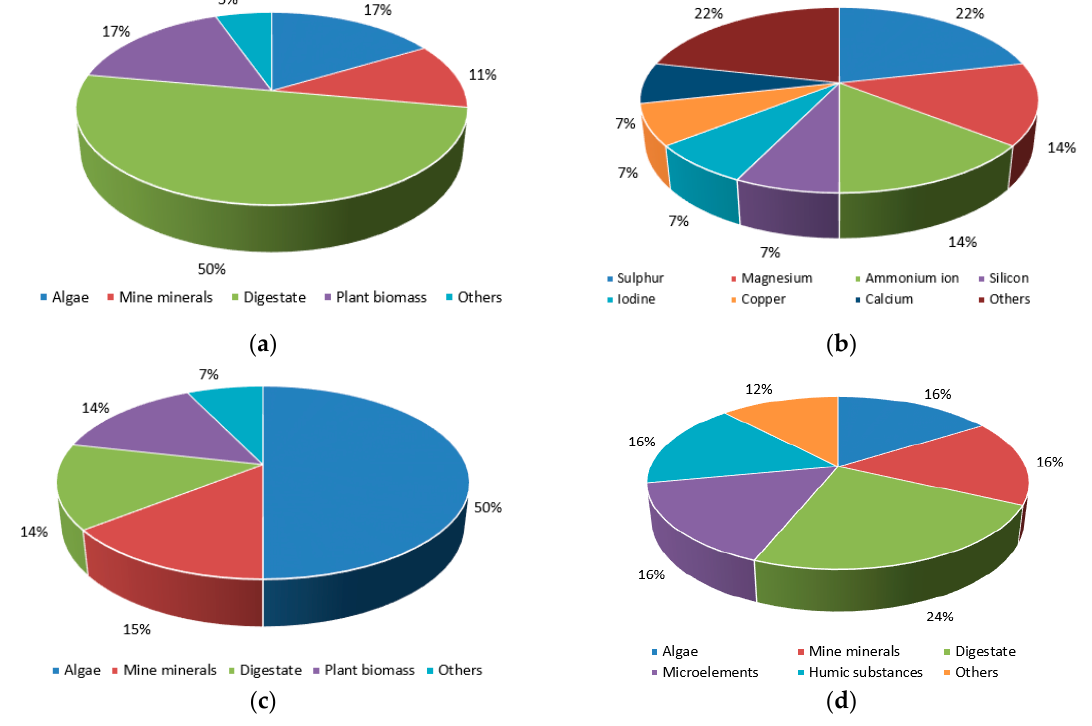
Figure 2. Input materials (micronutrients in the case of mineral fertilizers) used in the production of liquid organic fertilizers ( a ), mineral fertilizers ( b ), organic–mineral fertilizers ( c ) and in the production of soil conditioners ( d ) (authors’ own elaboration based on Tables 7–10). Table 7. Selected organic fertilizers in liquid form (authors’ own elaboration based on [74] ). Commercial